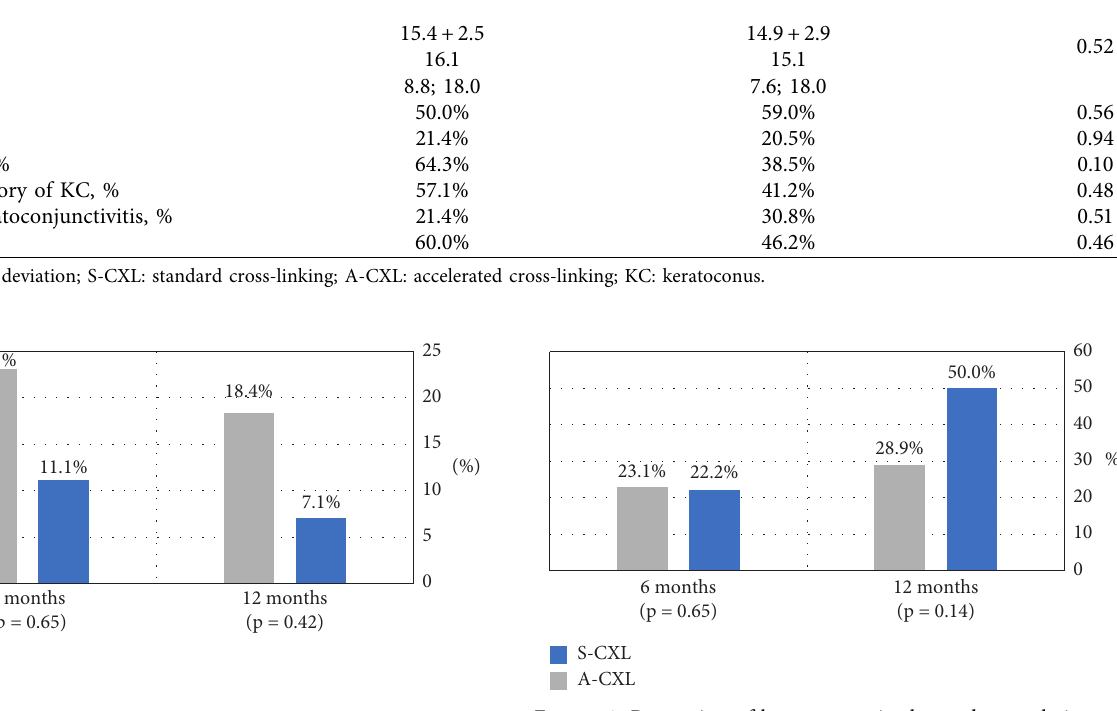
Figure 1: Progression of keratoconus in the study population at 6 and 12 months after CXL. Progression is defined as an increase of > 1D in K max . A-CXL: accelerated cross-linking; S-CXL: standard cross-linking; D: diopter; KC: keratoconus.